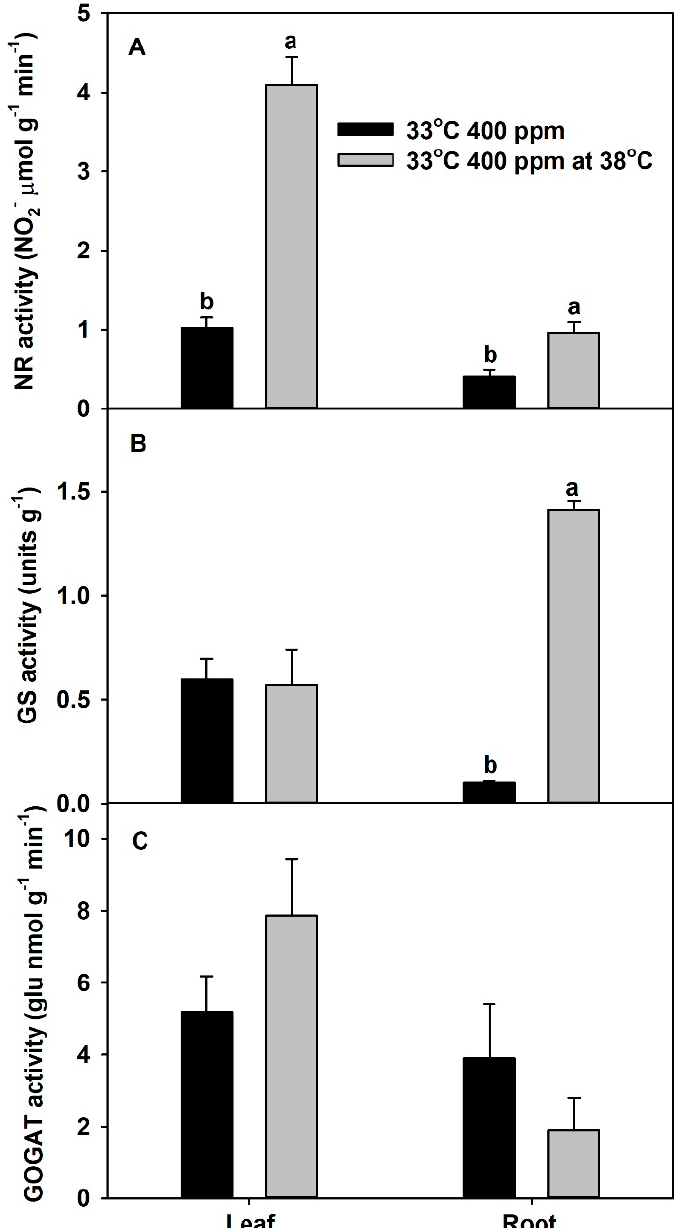
Figure 6. In vitro activities of ( A ) nitrate reductase (NR), ( B ) glutamine synthetase (GS), and ( C ) glutamine oxoglutarate aminotransferase (GOGAT), extracted from leaves or roots of Solanum lycopersicum plants grown at 33 ◦ C and 400 ppm and measured at both 33 and 38 ◦ C. Each bar represents mean ( n = 4) + 1 SEM. Within each panel, bars not sharing the same letters are significantly different ( p < 0.05, Tukey’s test); no letters are shown if no differences.